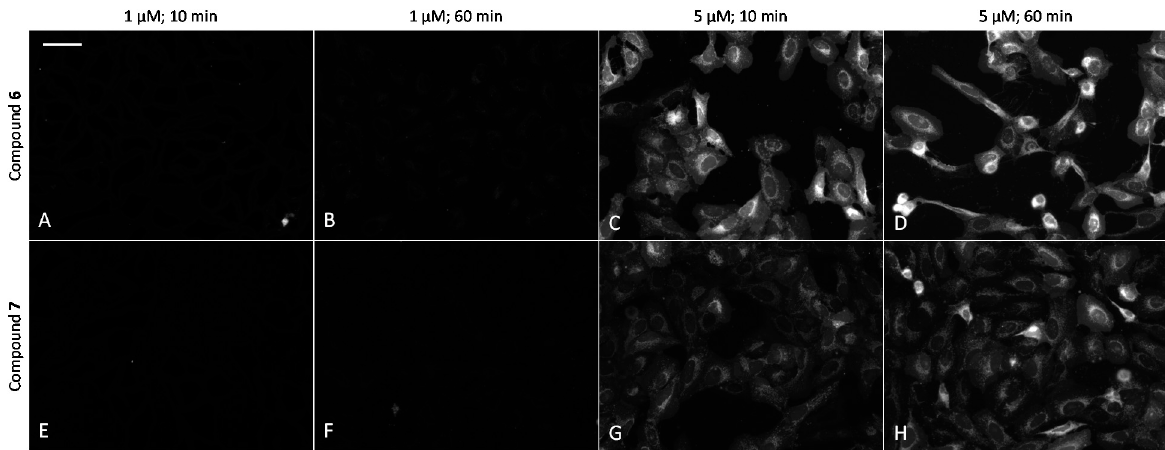
Figure 5. Comparison of cellular uptake of ARCs labeled with Cy5 dye into live U2OS cells. ( A – D ) compound 6 ; ( E – H ) compound 7 . Incubation conditions are listed above the images. Representative images from a single experiment are shown; in all wells, imaging settings were identical (see Materials and Methods section of the main text). Scale bar: 50 μ m.